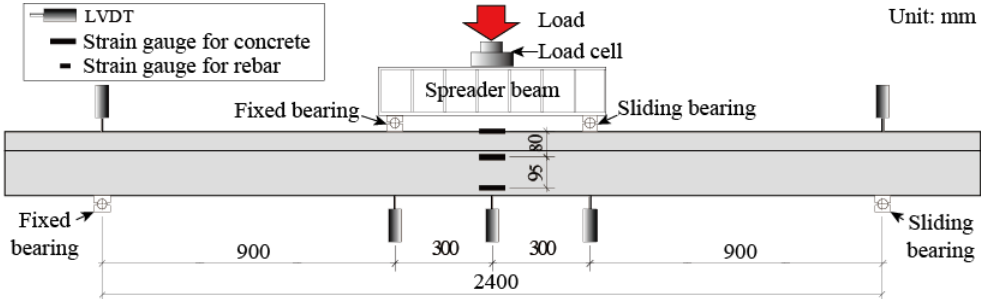
Figure 6. Load pattern and location of measuring instruments for load and displacement.